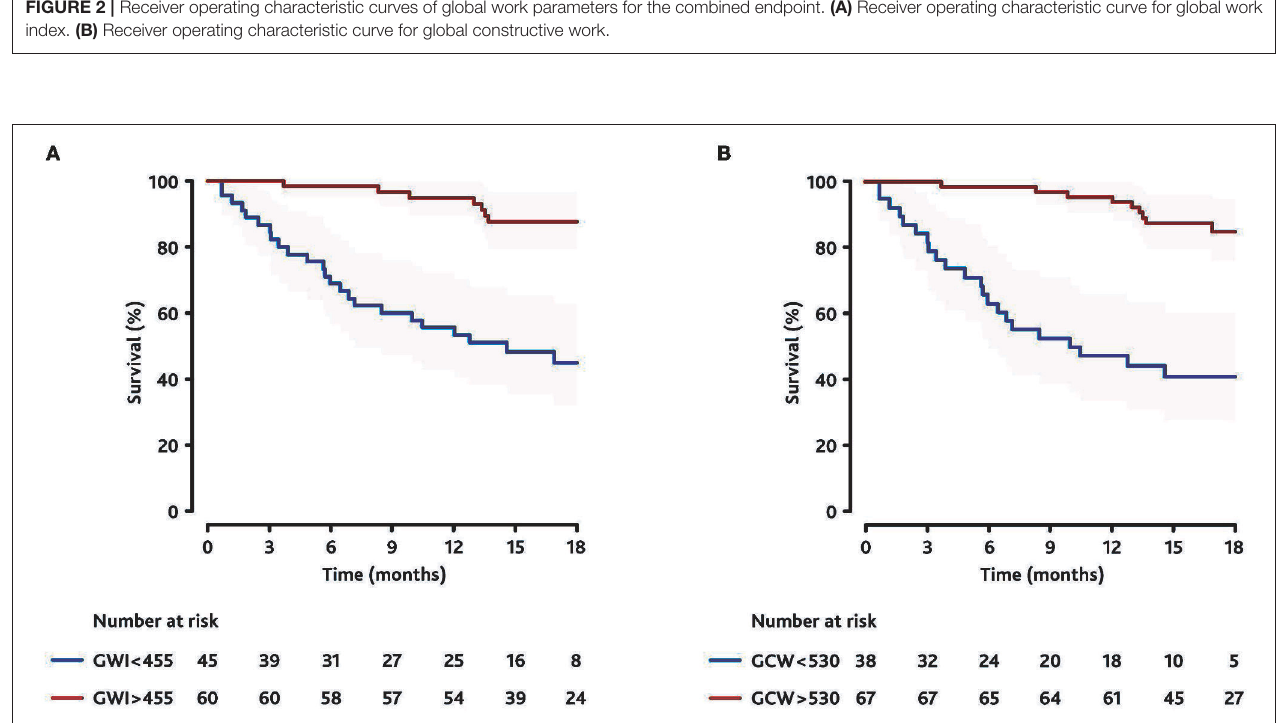
FIGURE 3 | Kaplan-Meier estimates of event-free survival dependent on global work parameters. (A) Kaplan-Meier estimates dependent on global work index (GWI). (B) Kaplan-Meyer estimates dependent on global constructive work (GCW). Cut-offs derived from receiver operating curves (see Figure 2 ).